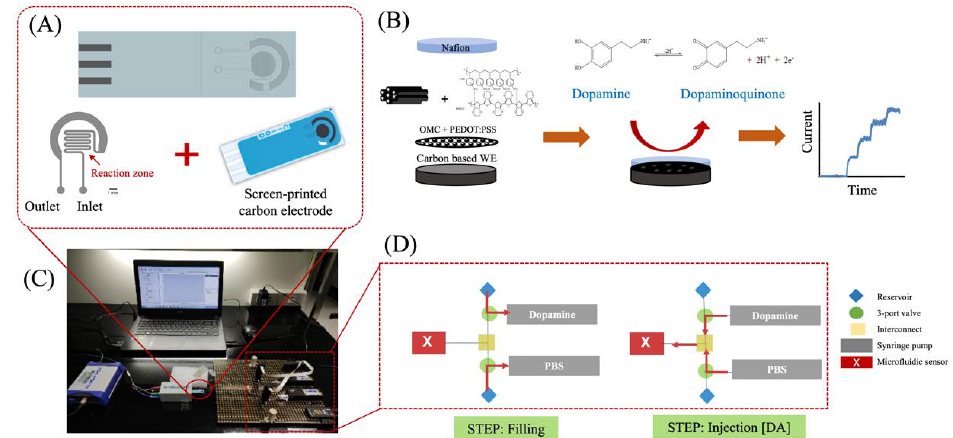
Figure 1. The developed microfluidic-based OMC-PEDOT-PSS sensor platform for dopamine monitoring system. ( A ) Integration of a serpentine PDMS based chip on a SPCE, serpentine pattern using Siemens NX software, ( B ) Schematic representations of the modification of OMC and PEDOT-PSS on a SPCE, ( C ) photo of the complete system of DA detection, and ( D ) the configuration of the developed computer-controlled microfluidic platform using LabSmith components.